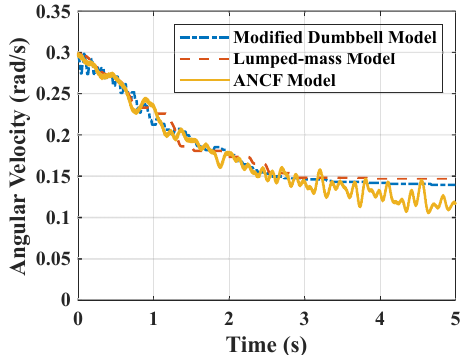
Figure 14. Angular velocity of the